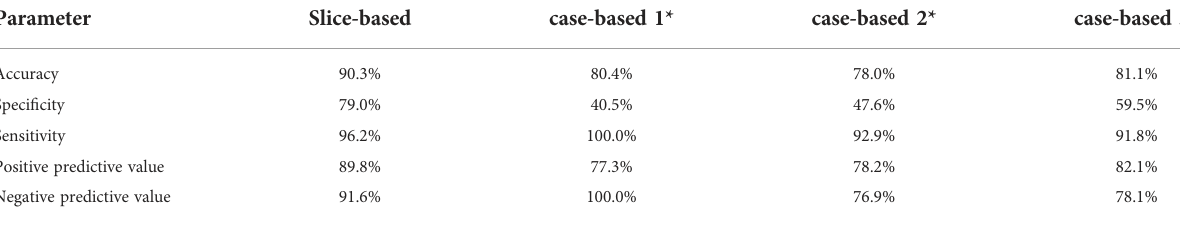
TABLE 3 Diagnostic Performances of the CNN model evaluated in slice-based and case-based method. Parameter Slice-based case-based 1* case-based 2*